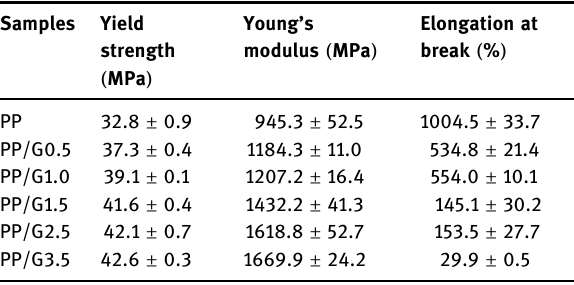
Table 4: Tensile mechanical properties of neat PP and PP/GNP nanocomposites